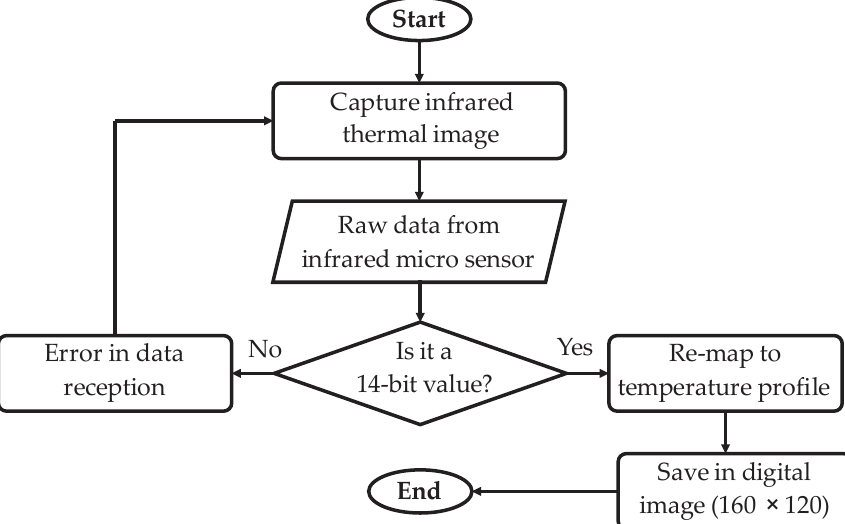
Figure 4. Flow diagram of the preprocessing module implementation.